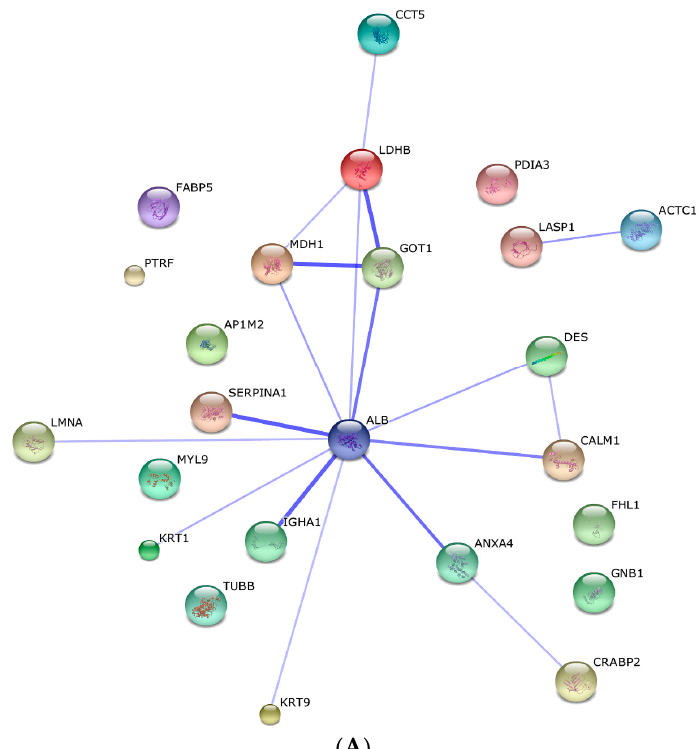
Figure 3. Cont. Figure 3.